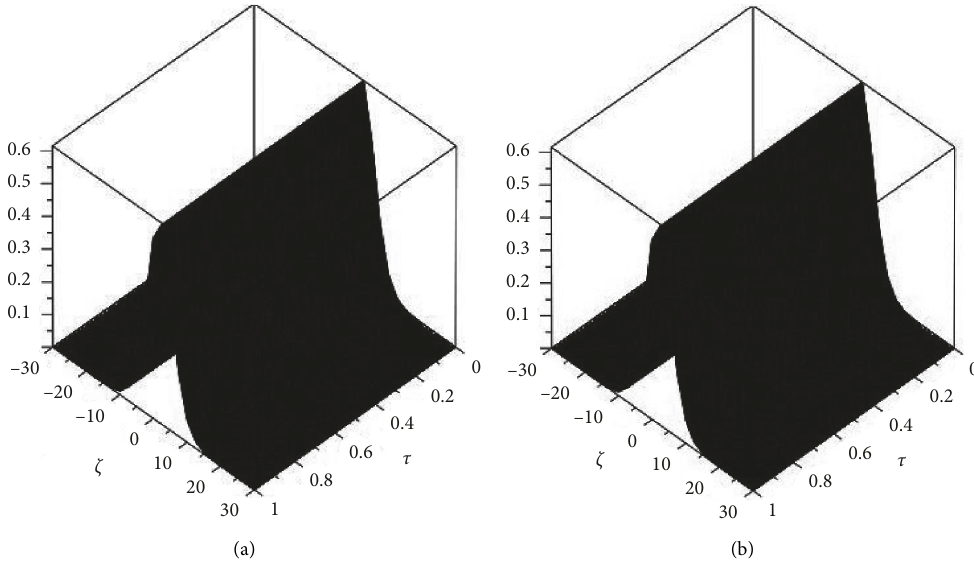
Figure 5: Graph of (a) exact and (b) analytical results of β � 1 of Example